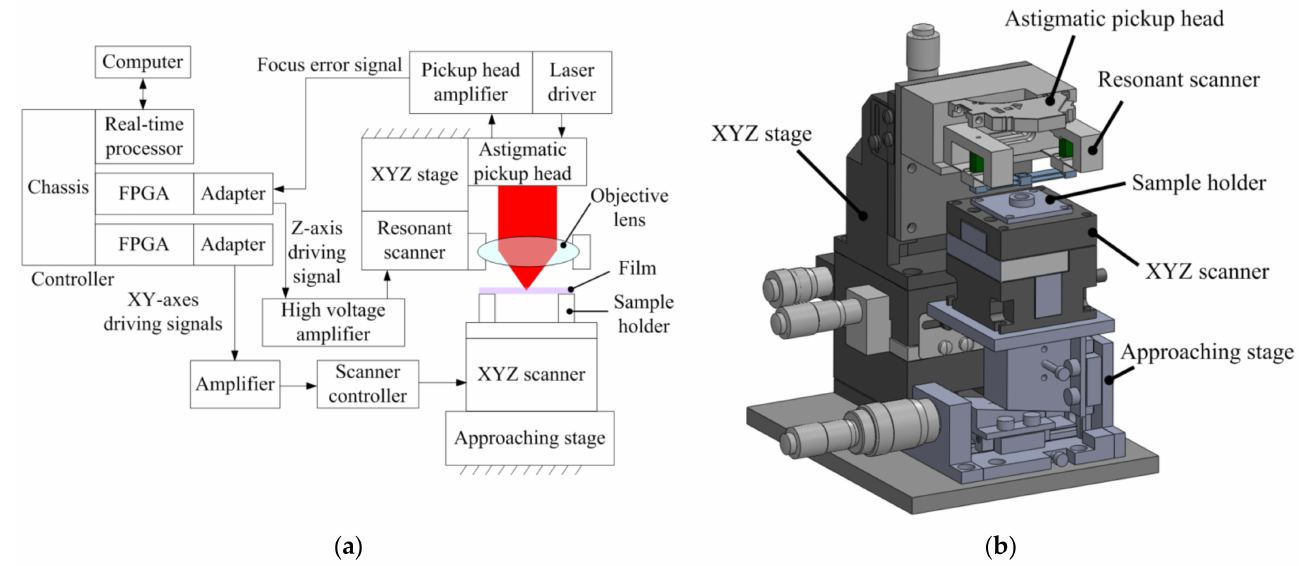
Figure 3. ( a ) System configuration and ( b ) mechanical design of astigmatic optical